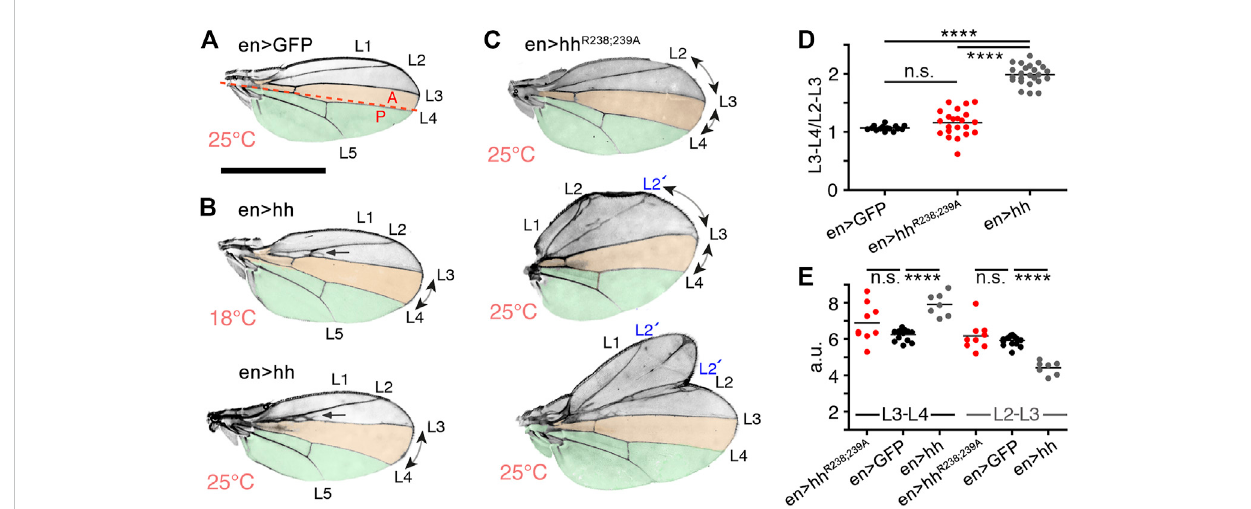
FIGURE 7 Substitution of HS-binding Hh amino acids affects Drosophila wing patterning. (A) En-GFP control fl ies only produce endogenous Hh in the posterior (P) wing disc compartment to directly pattern the later central domain of the adult wing (orange). The A/P boundary is indicated by the red dashed line. (B) Wing development in fl ies overexpressing Hh under en control at 18 ° C (B, weak Hh transgene expression) and 25 ° C (bottom, strong expression).TheL3-L4interveinregionisalwaysexpandedinen > hhwingsandtheL2-L3interveinregionisalwaysproximallyapposed(indicatedby arrows). (C) In en > hh R238;239A wings at 25 ° C, both intervein regions expand, and the formation of additional longitudinal L2 veins in the anterior compartment of en > hh R238;239A wings (labeled L2 ’ ) and mirror-image duplications of the anterior compartment (bottom wing) both support ectopic signaling as theunderlying cause. Scalebar: 1 mm. (D) ToquantifyHh activity, themostproximalL3-L4 areashighlightedinorange weredetermined and thevalues dividedbytheL2-L3areas.One-way ANOVA, two-tailed,Turkey`smultiple comparisons posthoc test.**** p ≤ 0.0001,n.s, p > 0.01. (E)